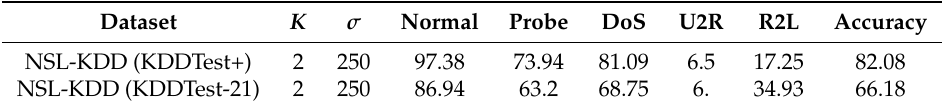
Table 5. Detection accuracy (%) with optimal parameters K and σ for NSL-KDD (KDDTest+) and NSL-KDD (KDDTest-21) datasets.